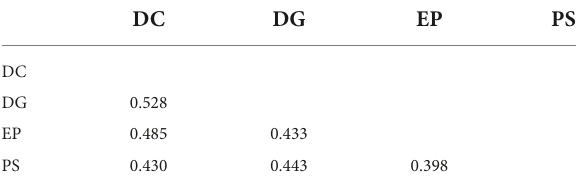
TABLE 5 Heterotrait–monotrait ratio.